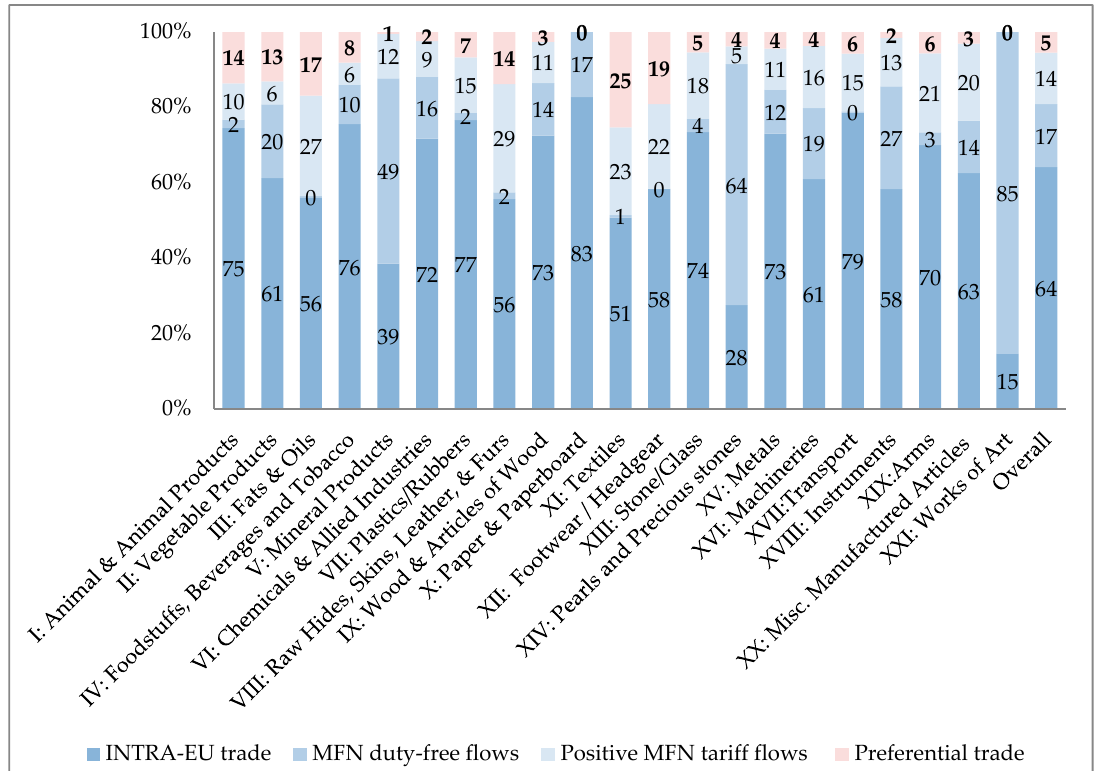
Figure 1. Structure of EU28 imports by section. Source: Elaboration on data by COMEXT and TRAINS; 2017.